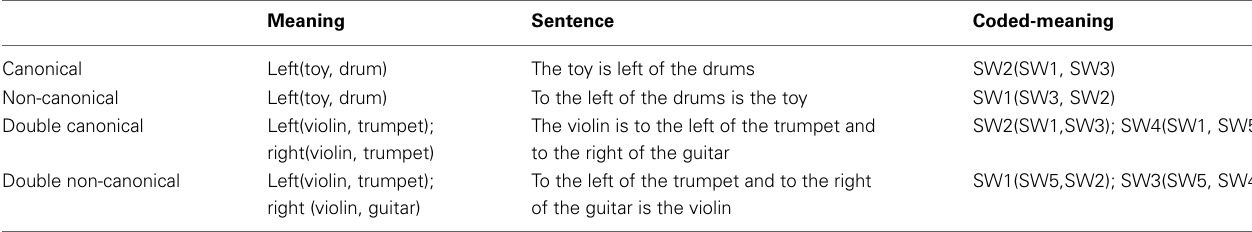
Table 1 | Representation and form of canonical and non-canonical sentences.